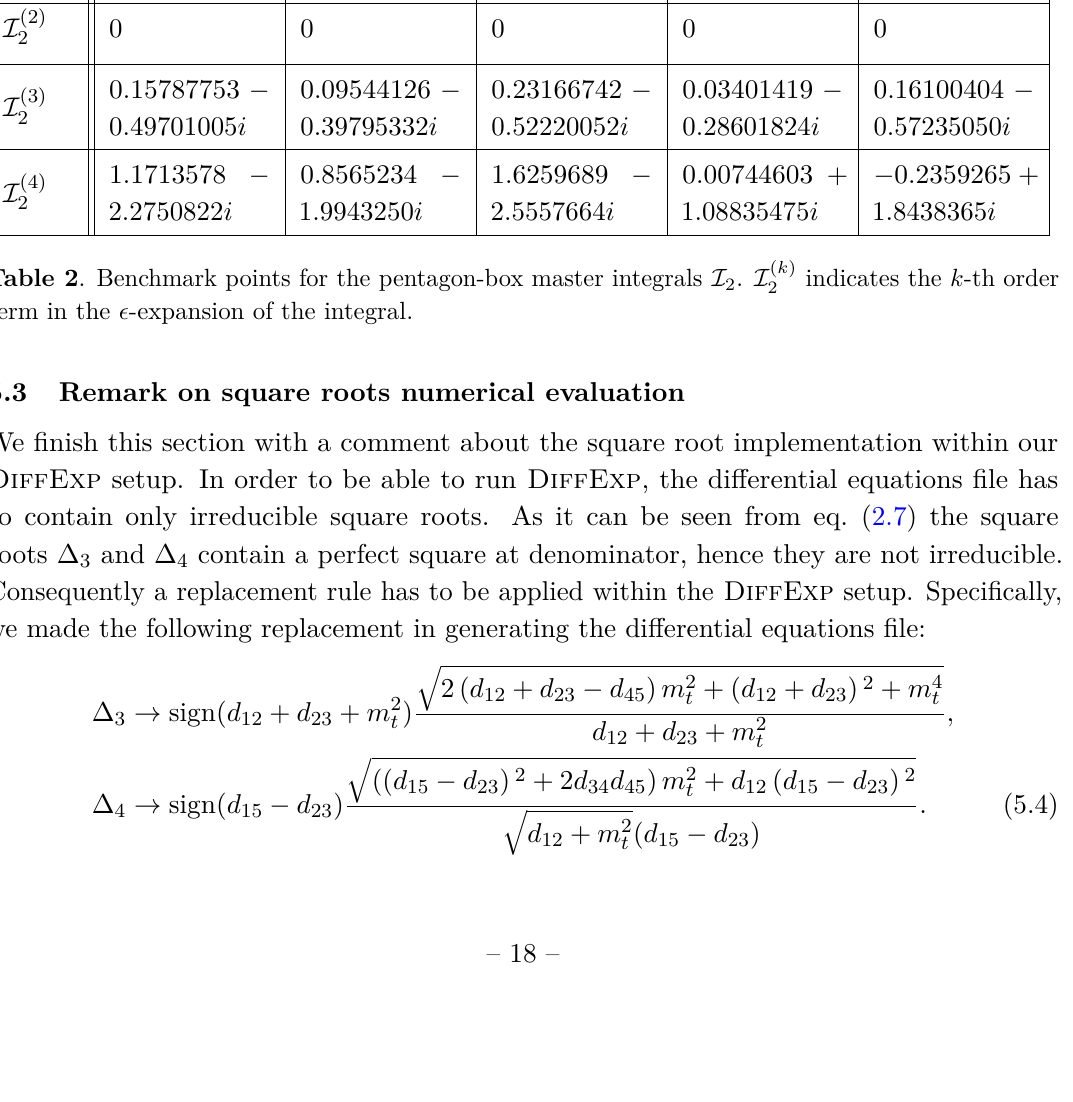
Table 2 . Benchmark points for the pentagon-box master integrals I 2 . I ( k )